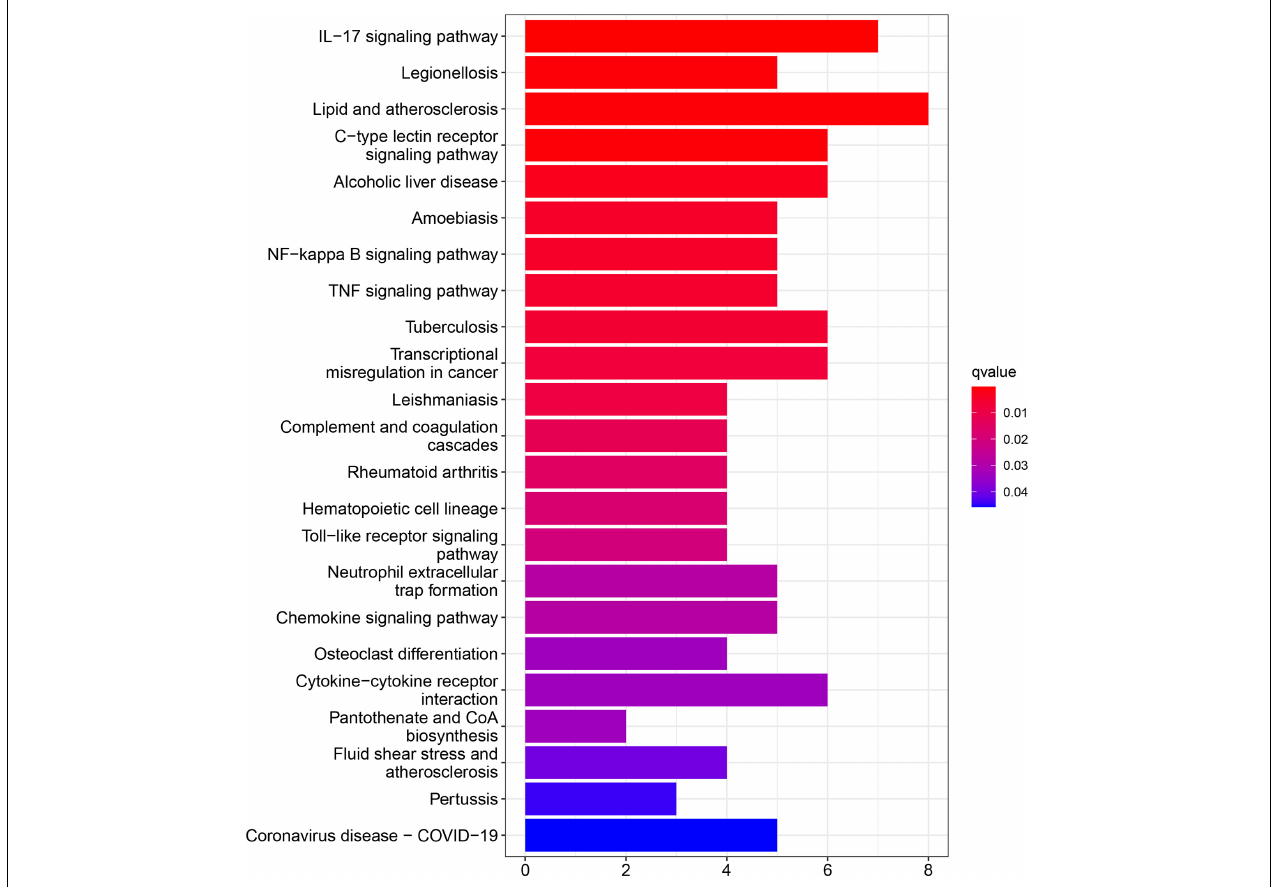
FIGURE 4 | Kyoto encyclopedia of genes and genome (KEGG) pathway enrichment analysis of DEGs in AMI.